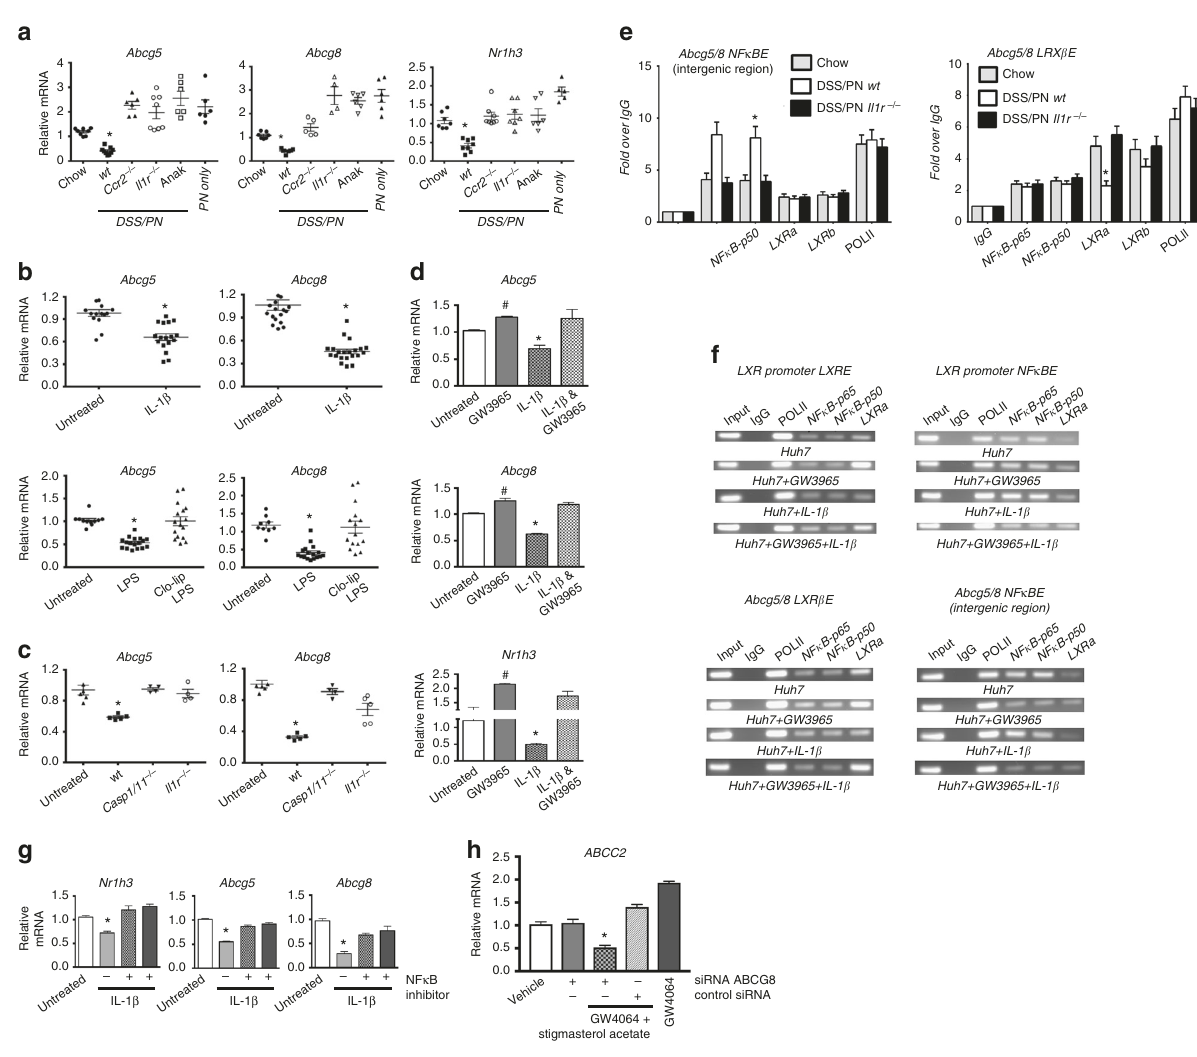
Fig. 5 IL-1 β induced NF- κ B signaling suppresses LXR and ABCG5/8 . a Liver mRNA for Abcg5 , Abcg8 , and Nr1h3 in WT chow mice relative to WT DSS/PN, WT PN-only, Ccr2 − / − DSS/PN, Il1r − / − DSS/PN, and Anakinra DSS/PN mice. b , c Liver mRNA for Abcg5 and Abcg8 in WT mice left untreated, or IL-1 β i.p. injected (4 h) (upper panels) and in mice LPS i.p. injected (4 h), with or without prior (16 h) i.p. clodronate-liposome (Clo-lip) injection (bottom panels). * p < 0.05 vs. all other groups using t test (upper panels) or one-way ANOVA and Tukey's correction (lower panels). c Liver mRNA for Abcg5 and Abcg8 in WT mice left untreated, or i.p. LPS injected relative to that Casp1/11 − / − and Il1r − / − mice. d Liver mRNA for Abcg5 , Abcg8 , and Nr1h3 in untreated mouse primary hepatocytes relative to LXR agonist (GW3965, 2 μ M, 16 h) and IL-1 β (additional 4 h) treatment. e qPCR from LXR β binding site within the ABCG5/8 intergenic region and ChIP for LXR α or NF- κ B p65 and p50 on liver homogenate from WT chow, WT DSS/PN, and Il1r − / − DSS/PN mice. Data represented as fold change over IgG; POLII shown as control. f ChIP from HuH7 cells left untreated (HuH7), or exposed to LXR agonist (GW3965, 2 μ M; HuH7 + GW3965) for 16 h with or without additional exposure to IL-1 β for 4 h. Speci fi c antibodies for either LXR (left) binding to LXR promoter (top left) or ABCG8 intergenic region (bottom left) or NF- κ B p50 and p65 (right) binding to the LXR promoter (top right) or ABCG8 intergenic region (bottom right). g Relative mRNA in primary mouse hepatocytes for Nr1h3 , Abcg5 , and Abcg8 exposed to IL-1 β (2 ng/ml) with or without prior exposure (1 h) to NF- κ B inhibitor (BAY- 11-7082, 50 μ M. h mRNA for ABCC2 in HepG2 cells exposed to transfection reagent (vehicle) or control siRNA and ABCG8 siRNA and exposure to FXR agonist GW4064 (5 μ M) with and without stigmasterol acetate (20 μ M) ( d , g , h depict mean ± SEM of technical triplicates from one representative out of at least fi ve experiments). a , d , g * p < 0.05 vs. all other treatments using one-way ANOVA and Tukey's exposed HuH7 cells with an LXR agonist increased LXR binding NF- κ B binding to Nr1h3 and Abc5/8 promoters as the mediator and suppressed NF- κ B binding to the NR1H3 and ABCG8 pro- of the IL-1 β suppression of Abcg5/8 in PNAC mice. moters (Fig. 5f) and partially reversed the IL-1 β -mediated sup- Finally, we determined if reduced expression of ABCG5/8 is pression of NR1H3 and ABCG5/8 mRNA levels (Fig. 5d). In permissive for phytosterols to interfere with FXR target gene addition, in vitro overexpression of p50 or p65 subunits in HuH7 expression. We used a small interfering RNA (siRNA) approach cells resulted in a dose-dependent suppression of LXR activity to reduce expression of ABCG8 in HepG2 cells (resulting in ~90% using an LXR reporter construct, while simultaneous over- reduction in mRNA for ABCG8 , Supplementary Fig. 5E, F), expression of an NF- κ B repressor increased LXR activity (Sup- which were subsequently exposed to an FXR agonist (GW4064, 5 μ M; Tocris Bioscience, UK) combined with stigmasterol acetate plementary Fig. 5D). Finally, inhibition of NF- κ B in HuH7 cells exposed to 2 ng/ml IL-1 β increased mRNA expression of Abcg5/8 (10 μ M), a phytosterol with excellent solubility 26,47 and shown by us to promote PNAC and by others to suppress FXR and Nr1h3 (Fig. 5g). Taken together, these data support a role for